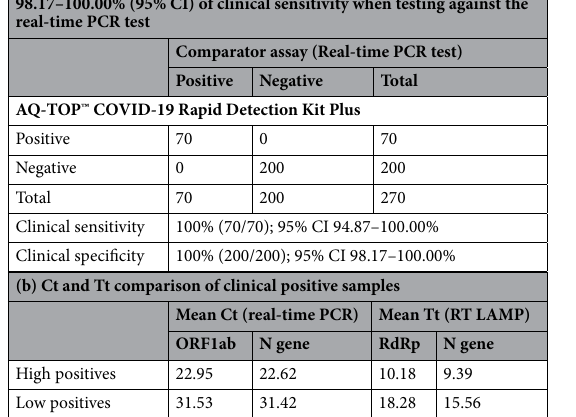
Table 3. Summary of clinical evaluation results.